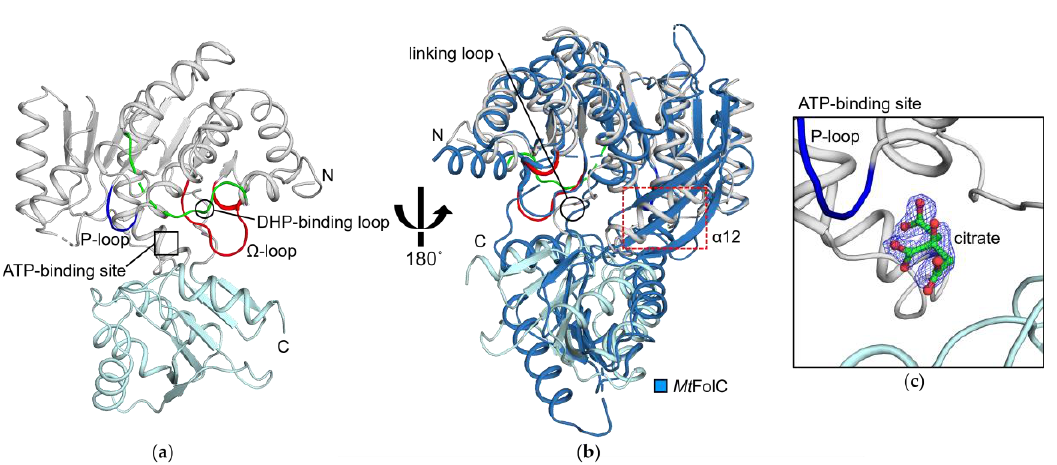
Figure 2. The overall structure of Hp FolC. ( a ) The crystal structure of Hp FolC is shown in a cartoon representation. The N- and C-terminal domains are colored in white and pale cyan, respectively. The dihydropteroate (DHP)-binding loop, P-loop, and Ω -loop are colored in green, blue, and red, respectively. The ATP-binding site is marked with a black solid square. ( b ) The structure of Hp FolC from ( a ) is rotated horizontally by 180 ◦ . In addition, the crystal structure of Mycobacterium tuberculosis FolC ( Mt FolC) (PDB code: 2VOR) is superposed and colored in blue. The loops linking the N- and C-terminal domains in Hp FolC and Mt FolC are marked with a black solid circle, and the helix α 12 region of Hp FolC is marked with a red square. ( c ) The ATP-binding site of Hp FolC shown in ( a ) is magnified. The bound citrate in the crystal structure of Hp FolC is shown with green sticks, and its 2mFo - DFc electron density map is shown with blue meshes at a 1.5σ contour level. Oxygen atoms are colored in red.